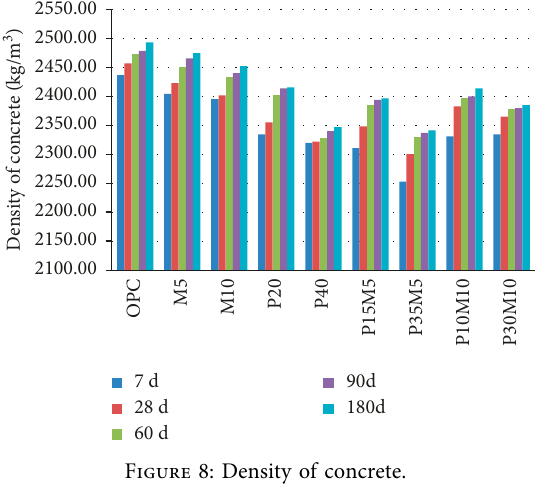
Figure 8: Density of concrete.